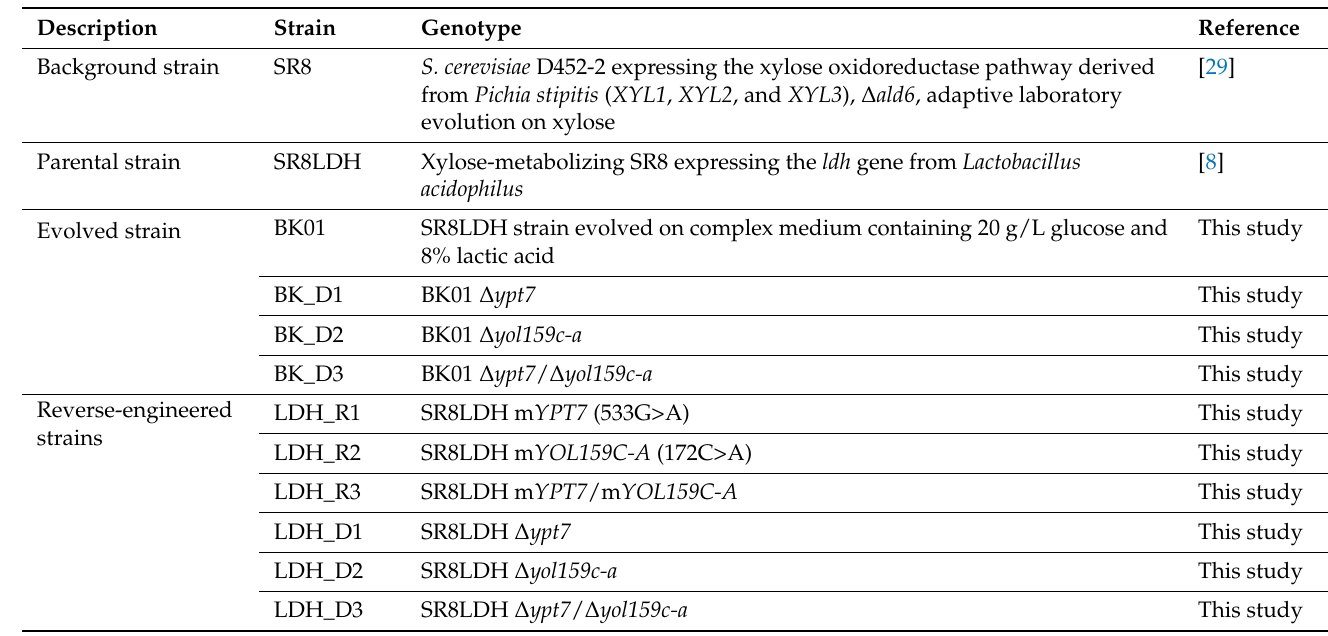
Table 1. Strains used in this